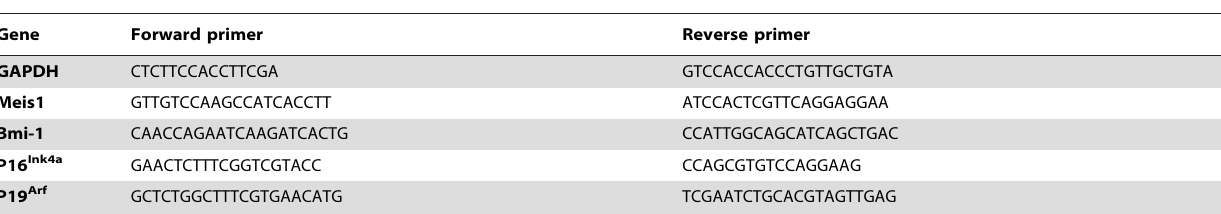
Table1. List of primers used for Real-time PCR.